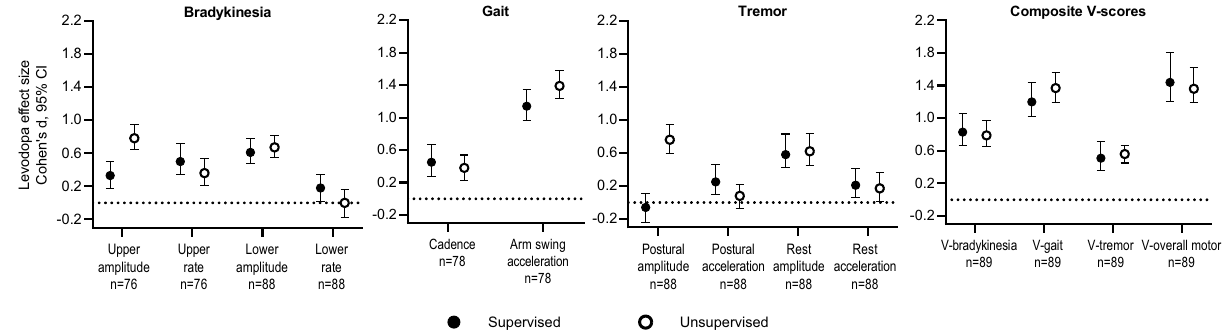
Figure 5. Clinical validity of digital measurements from single-sensor–derived features and composite V-scores as pharmacodynamic biomarkers: levodopa effect sizes calculated using sensor data collected during the supervised MDS-UPDRS Part III and unsupervised VME on Day 3 of the inpatient assessment. Effect sizes were calculated using Cohen’s d. Effect sizes of 0.2 were considered small, 0.5 were considered medium, 0.8 large, and > 1.2 very large. The smartwatch sensor data were collected during the investigator-supervised MDS-UPDRS Part III examination and during the unsupervised VME on Day 3 of the inpatient assessment; the averages of all scores on Day 3 were combined for each measure. CI confidence interval, MDS-UPDRS Movement Disorder Society-sponsored revision of the Unified Parkinson’s Disease Rating Scale, V-score machine-learned composite sensor scores for each motor feature, VME virtual motor examination.